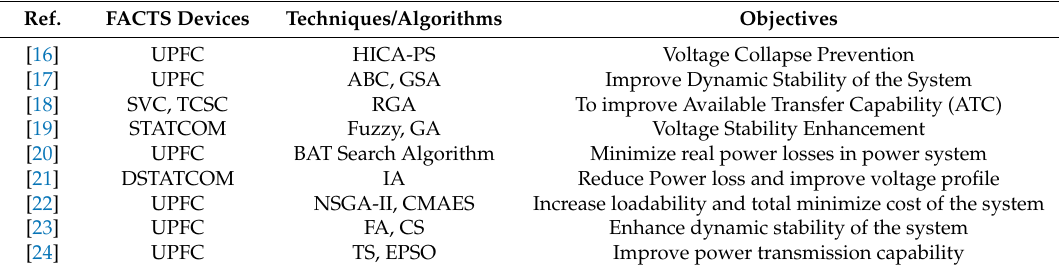
Table 1. Some techniques used for optimal location of FACTS